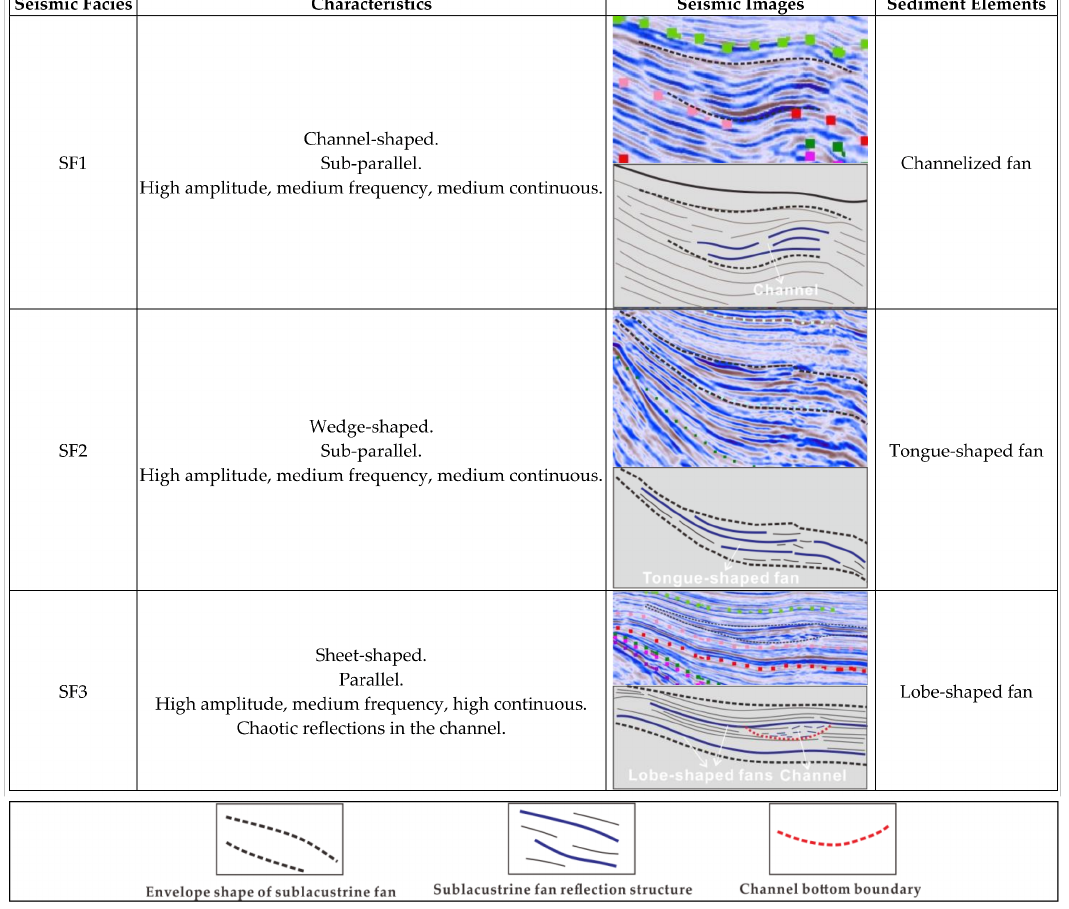
Figure 9. Seismic facies characteristics of different sublacustrine fans. Figure 10 indicates that the paleomorphology in the study area is composed of three units, including uplift, slope, and basin floor. In the uplift area, there are two canyons (A and B in Figures 10A and 11), from where the sediments in the distal braided river delta front entered the uplift area. The slope area has different slope break systems due to the existence of faults (Figure 10A). Region A is a single fault slope break system, region B is multiple faults slope break system, and region C is a sedimentary slope break system (Table 2). Moreover, the slope gradient in different areas is also different. By measuring the two-dimensional plane distance ( ∆ L) and three-dimensional space distance ( ∆ s) between two points of the measurement line, the angle formula is used α = Arccosine ( ∆ L/ ∆ s) gets the slope. During the period of TST, the slope of region B is 2.3 ◦ (Figure 10B), and the slope of region C is 0.8 ◦ (Figure 10C). In the HST, the slope of region A is 0.8 ◦ (Figure 10E). Table 2. Characteristics of three forms of sublacustrine